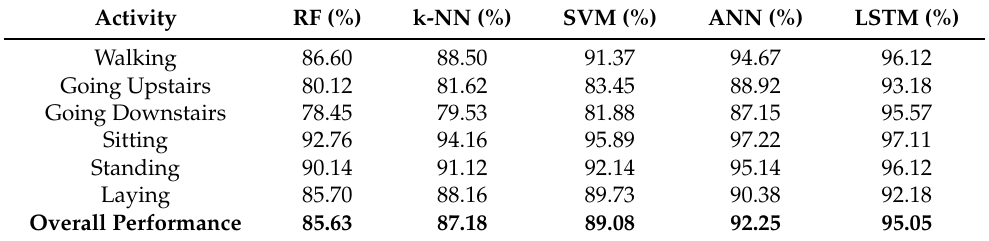
Table 2. Accuracy table of all the algorithms for each activity using 10-fold cross-validation.